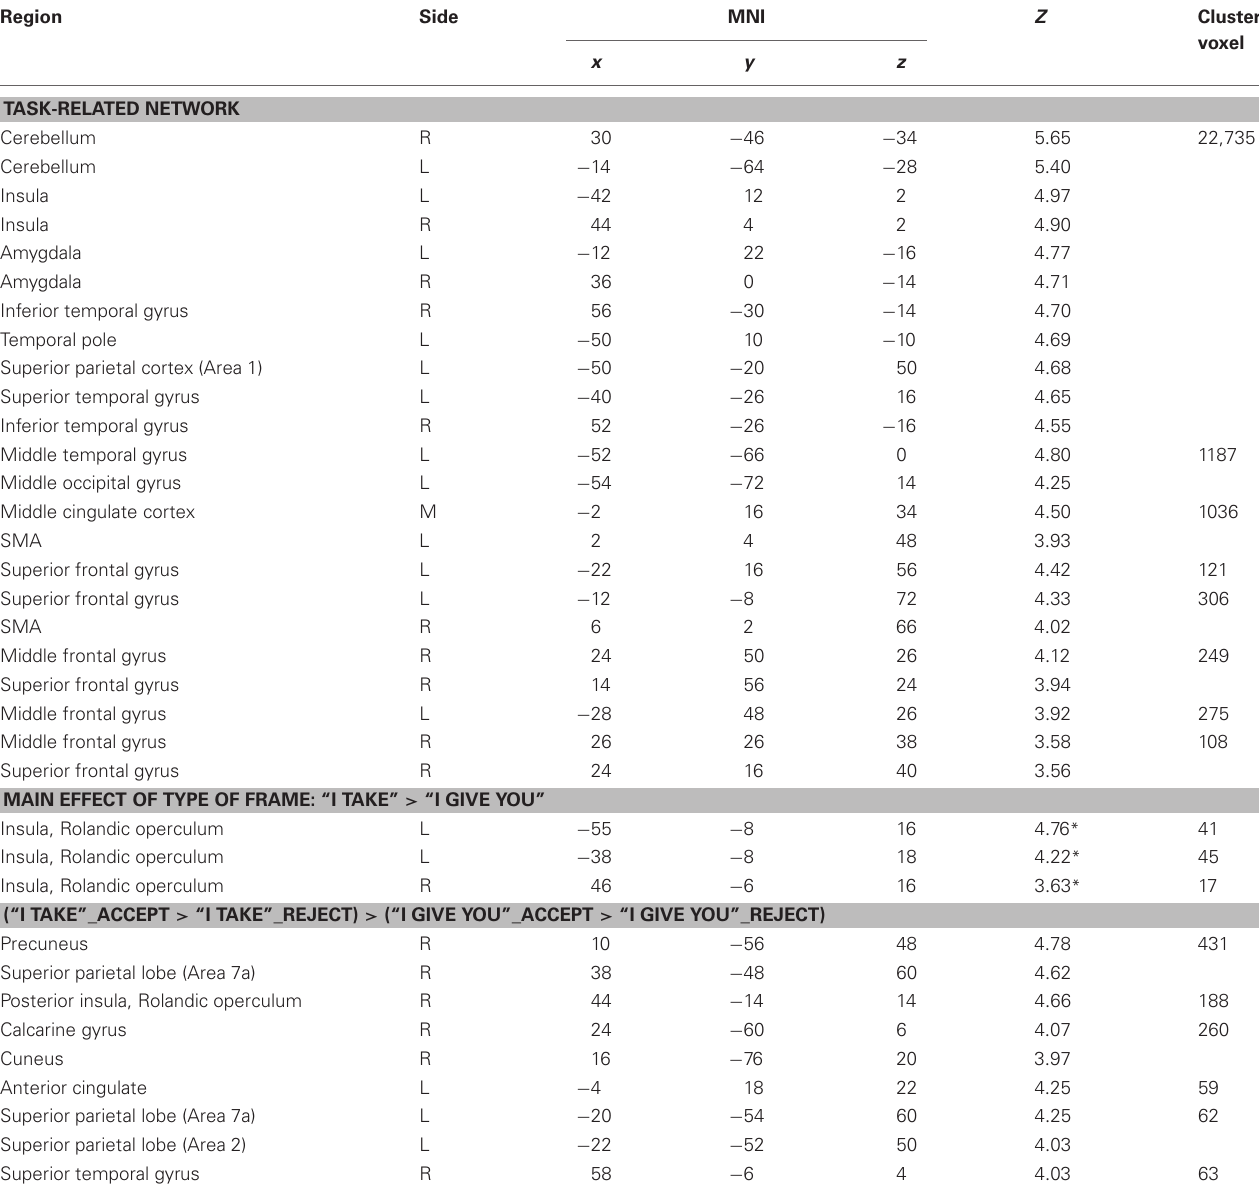
Table 1 | Whole brain analysis for the model accounting for frame and type of response related effects: brain regions showing significant relative increases of BOLD response associated with the experimental